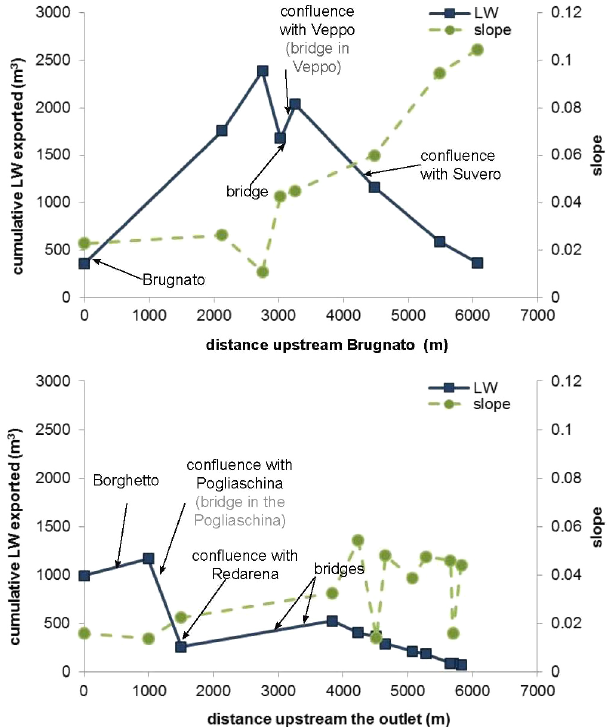
Figure 8. Cumulative LW exported and slope variability at reach scale along the longest flow paths in the Gravegnola (above) and Pogliaschina